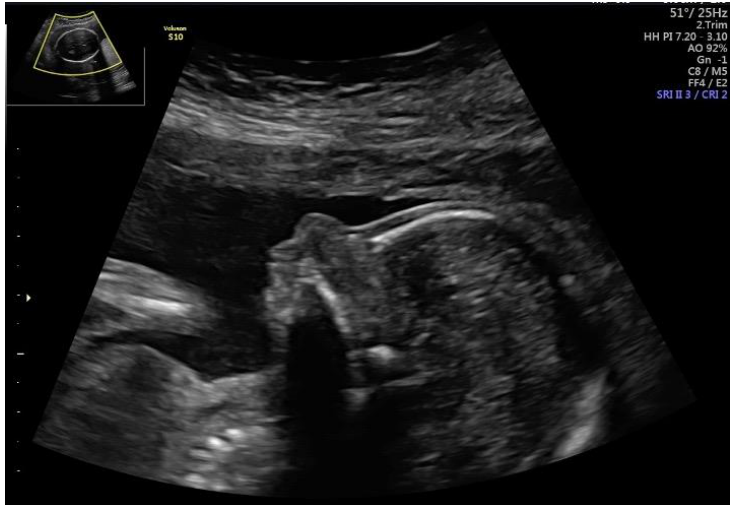
Figure 4. Fetus with focal dermal